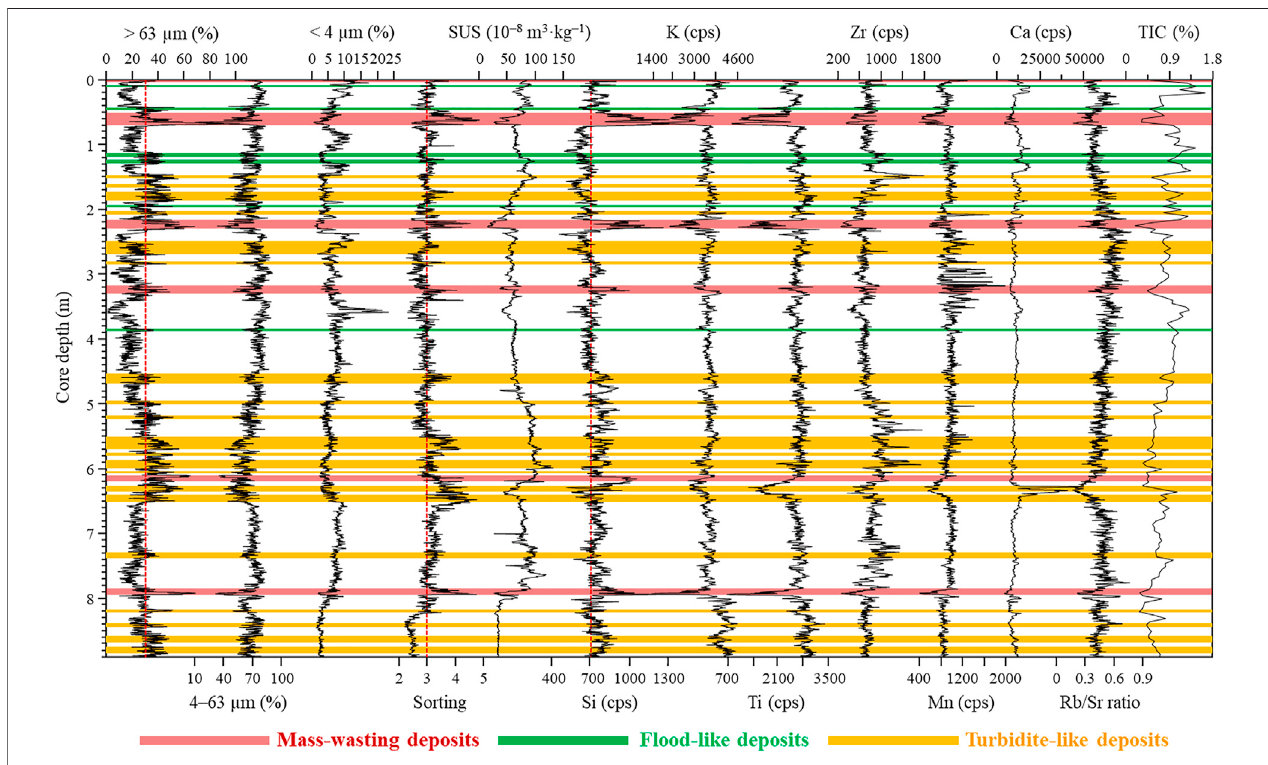
FIGURE 3 | Percentages of > 63, 4 – 63 and < 4 µm fractions, sorting index, magnetic susceptibility (SUS), major elemental contents, Rb/Sr ratio and total inorganic carbon (TIC) of the Y20B core. Red, green and yellow bars indicate the horizons of mass-wasting deposits (corresponding to Figures 2C – H ), fl ood-like deposits and turbidite-like deposits, respectively. Flood-like deposits have cross bedding structures and turbidite-like deposits generally have normally graded bedding sequences.